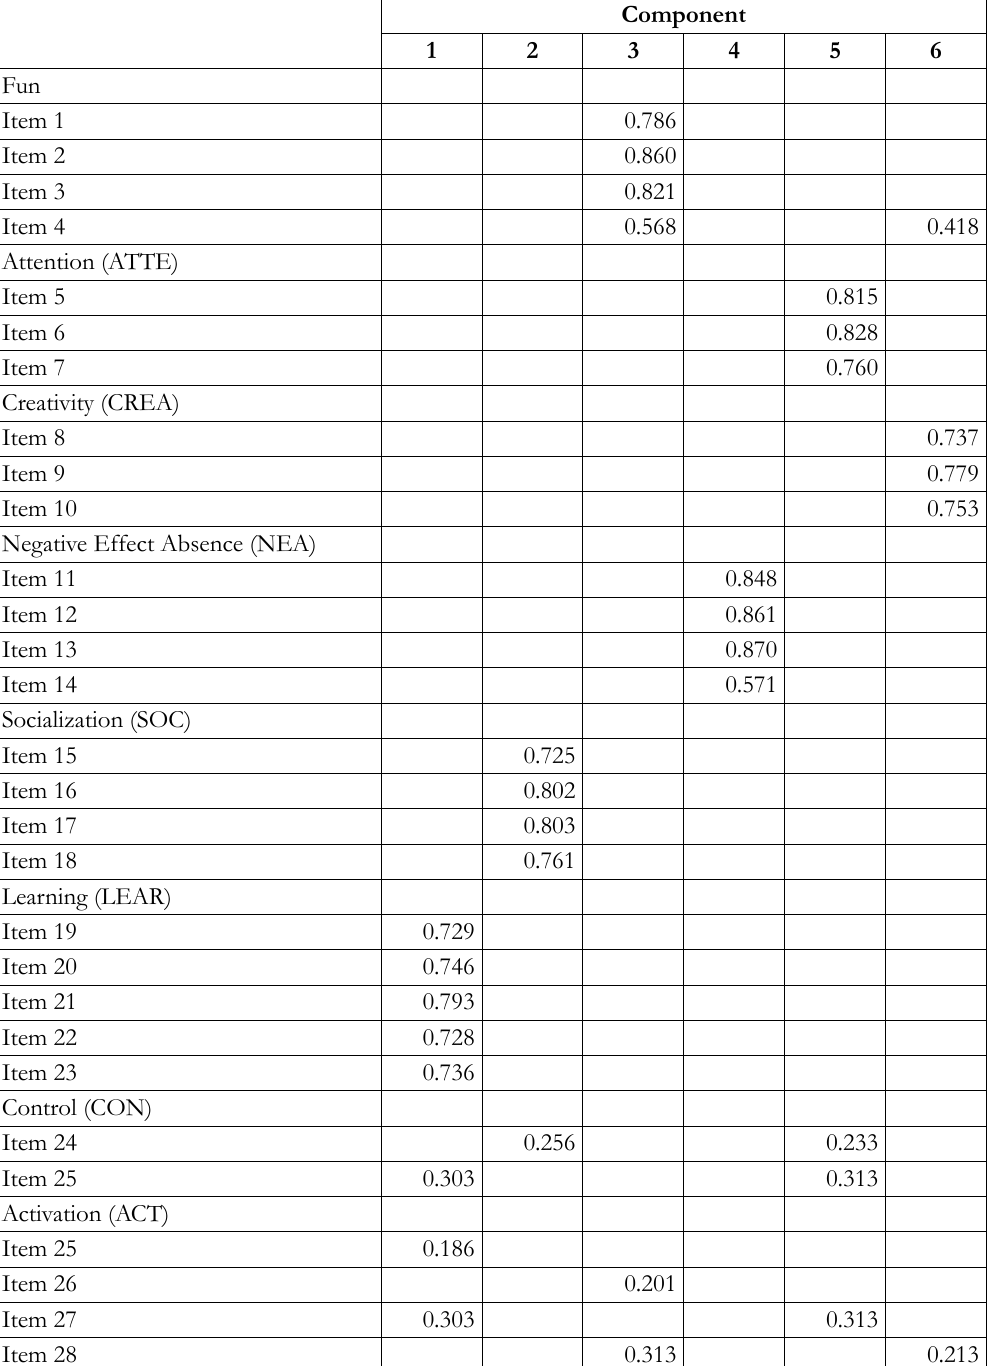
Table 1. Obtained components and load